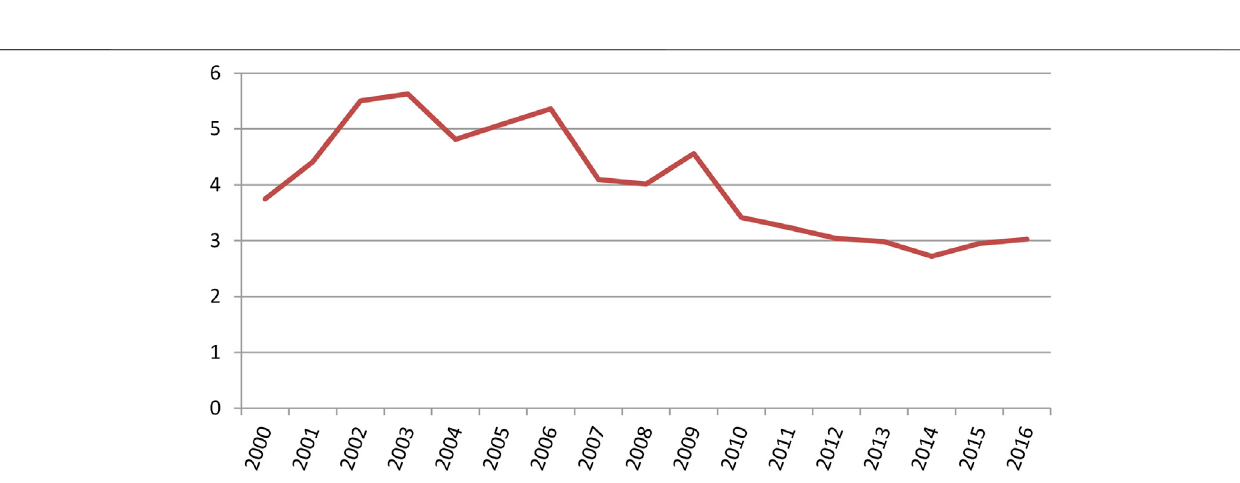
Frontiers in Environmental Science |